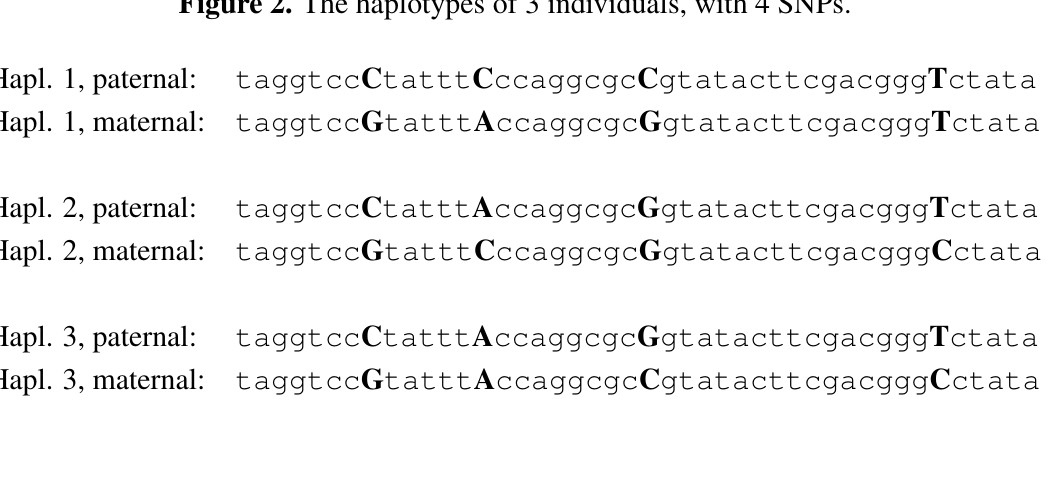
Figure 2. The haplotypes of 3 individuals, with 4